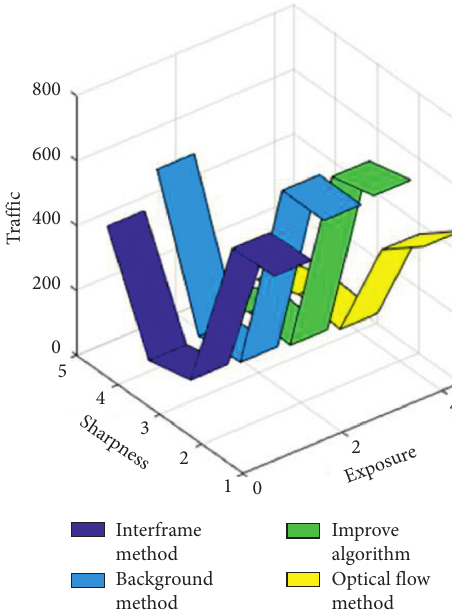
Figure 4: Pixel size